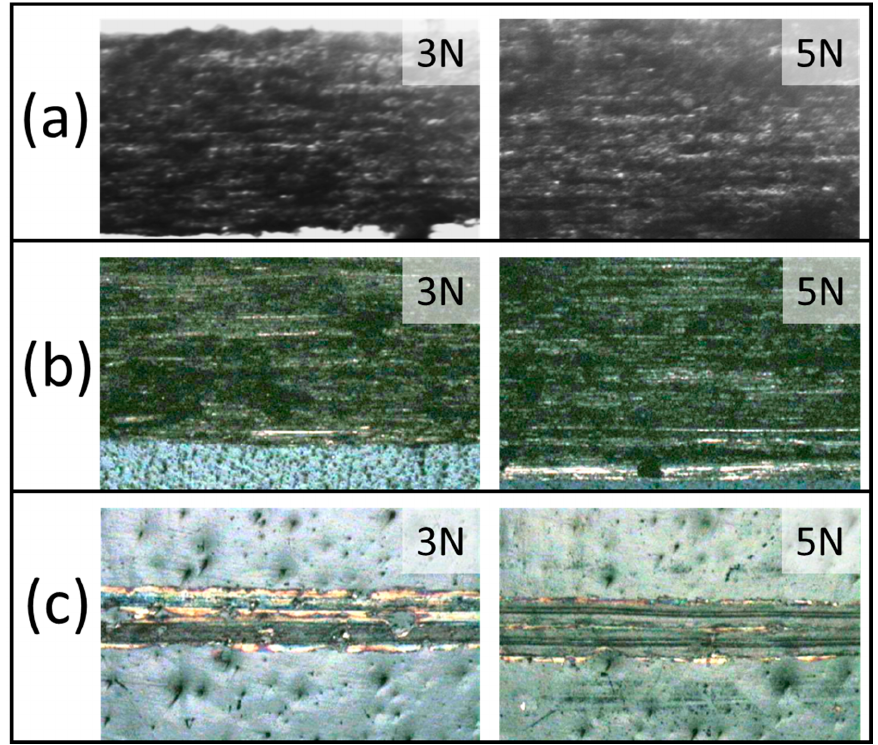
Figure 14. Optical micrographs of wear tracks at 3 and 5 N loads: ( a ) bare β -21S Ti-Mo alloy sub- strate, ( b ) Mo-DLC coating with 30 min deposition, and ( c ) Mo-DLC coating with 60 min deposi- tion.